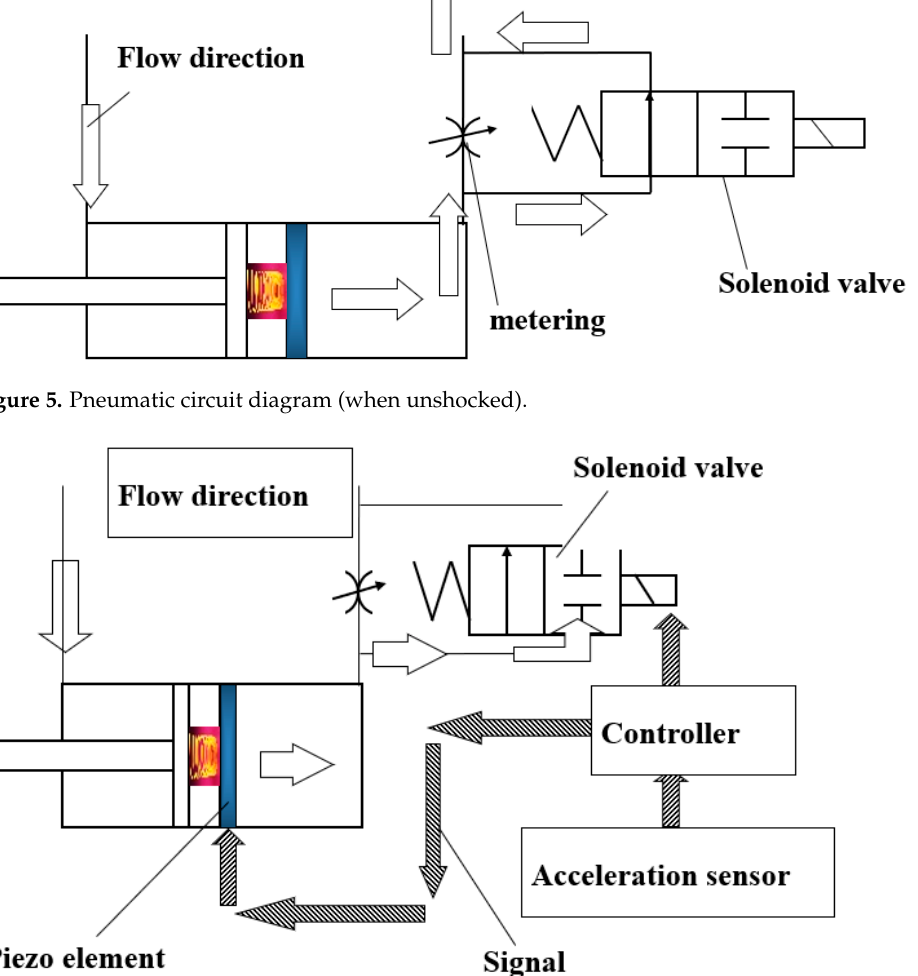
Figure 5. Pneumatic circuit diagram (when unshocked).